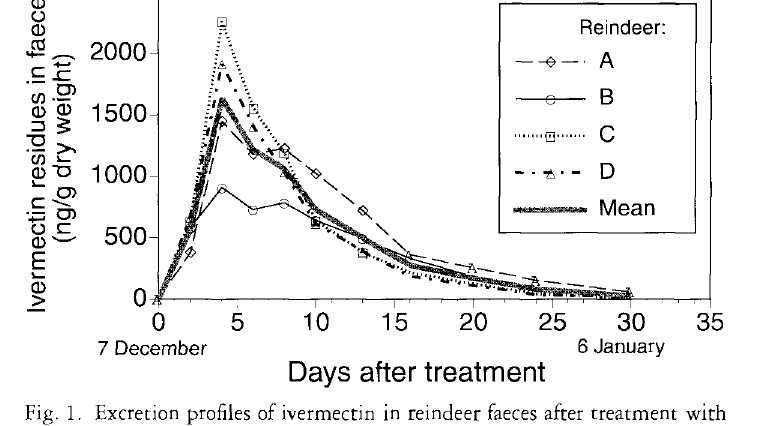
Fig. 1. Excretion profiles of ivermectin in reindeer faeces after treatment with a standard dose of ivermectin (0.2 mg ivermectin/kg body weight, injected subcutaneously). Values for each of the four reindeer and a combined mean value are